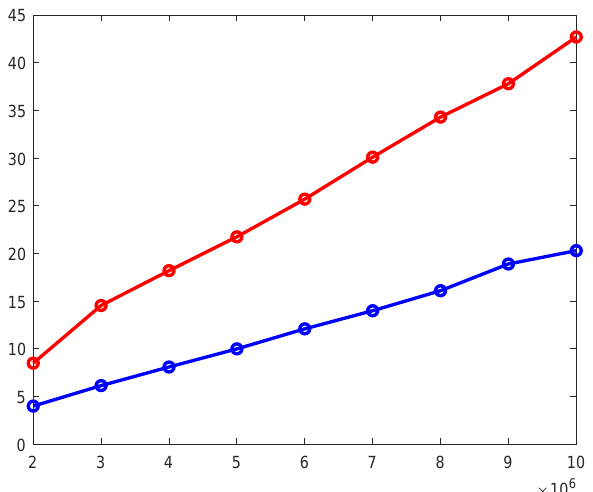
Figure 5. Runtime in seconds ( y -axis) for oversampling a minority class with different number of features ( x -axis) by Fast-SMOTE (blue line) and NDO (red